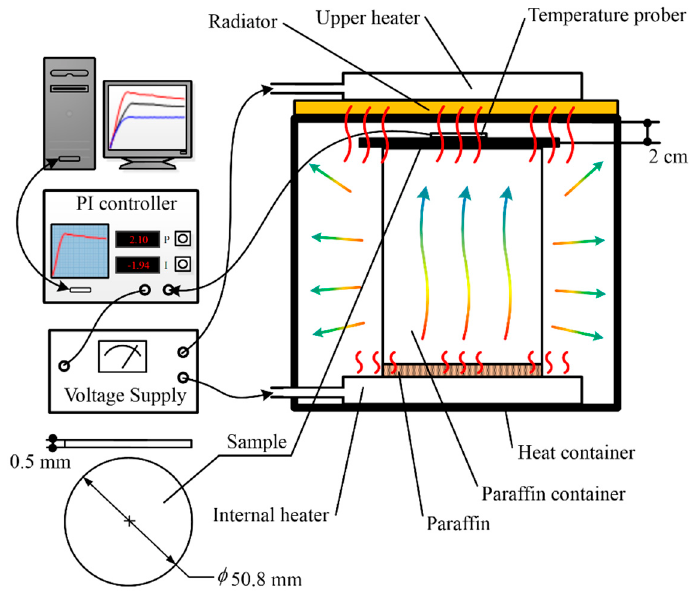
Figure 1. Three evaporation rigs of product paraffin coating: ( a ) open-type evaporation; ( b ) closed-type rapid cooling evaporation; and ( c ) closed-type precise temperature-controlled evaporation. Closed-type precise temperature-controlled evaporation and closed-type rapid cooling evaporation are collectively called closed-type evaporation.